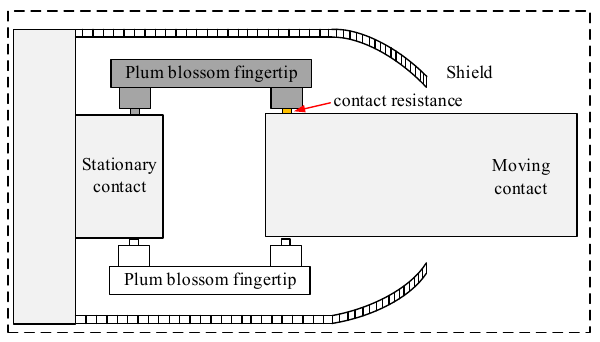
Figure 4. Detail of the structure of the geometric model of the tulip contact.